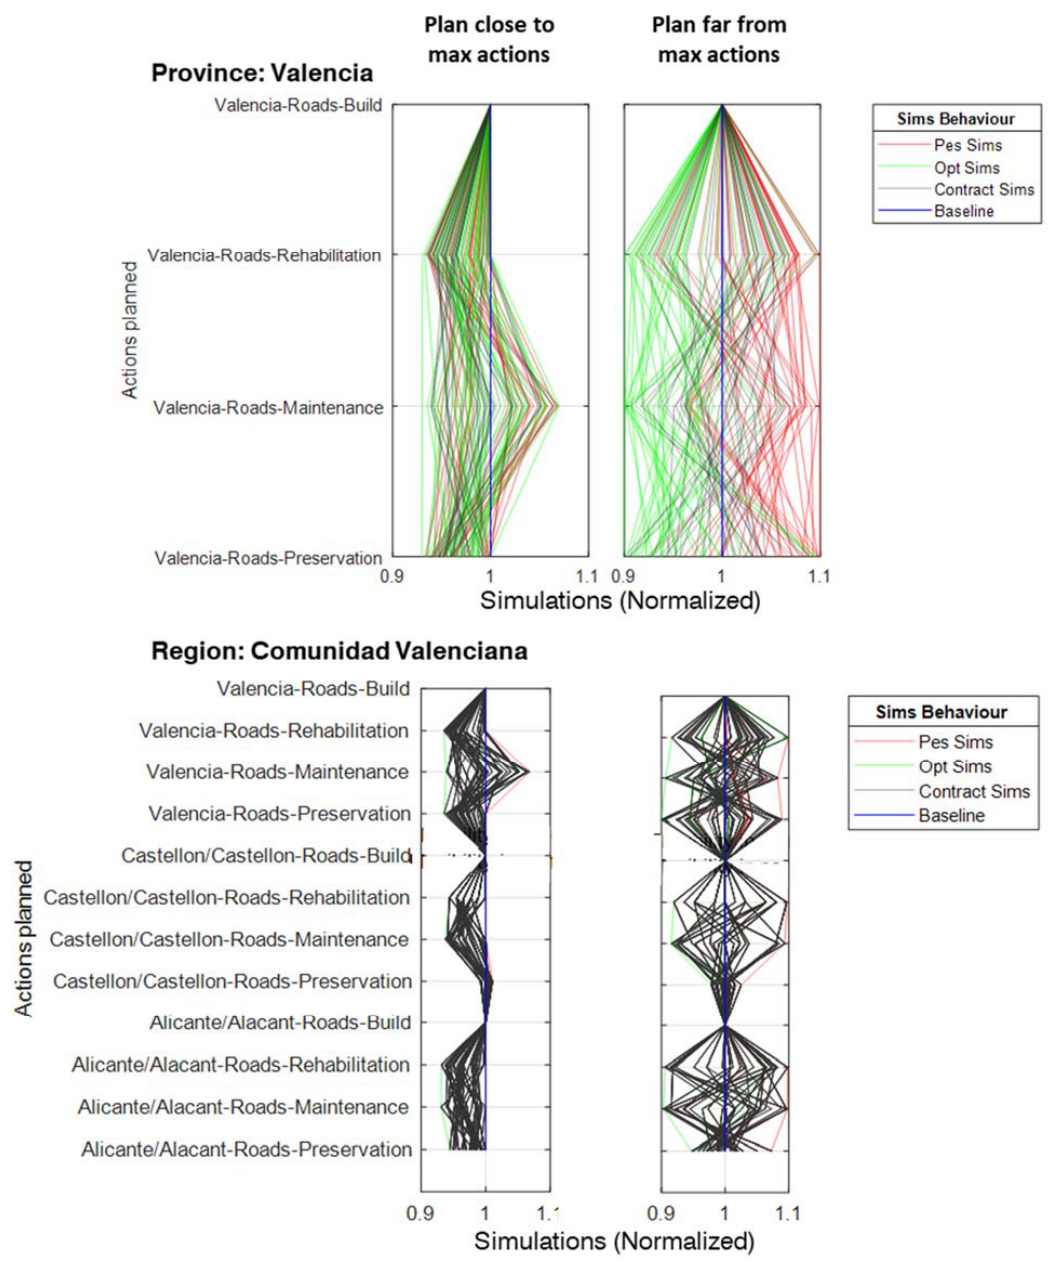
Figure 11. Example of simulations generated at provincial (bottom) and regional scales for different planning alternatives. Contractual simulations at the bottom scale were propagated to top scales. The decentralization configuration in both cases was the same.